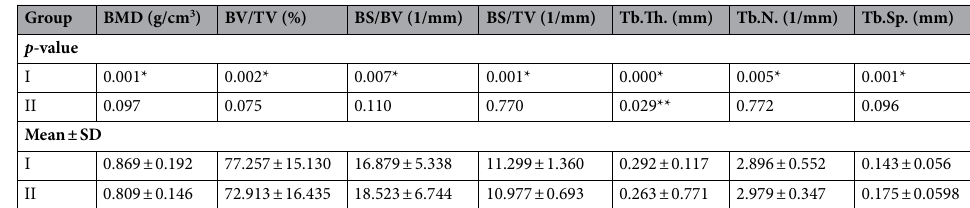
Table 5. Within group comparison and intergroup overall mean comparison of BMD and bone morphometry in the IP BRONJ model. The statistical analysis was performed using ANOVA for within group comparison. The data are depicted as p- values for within group comparison and mean ± standard deviation for intergroup overall comparison. BMD bone mineral density, BV/TV bone volume/total volume (bone volume fraction), BS/BV bone surface/segmented bone volume (specific bone surface), BS/TV bone surface/total volume (bone surface density), Tb.Th. trabecular thickness, Tb.N. trabecular number, Tb.Sp. trabecular separation. *Significant differences in BMD and bone morphometry parameters were found within group I ( p < 0.05). **Tb.Th. differed significantly within group II ( p < 0.05).